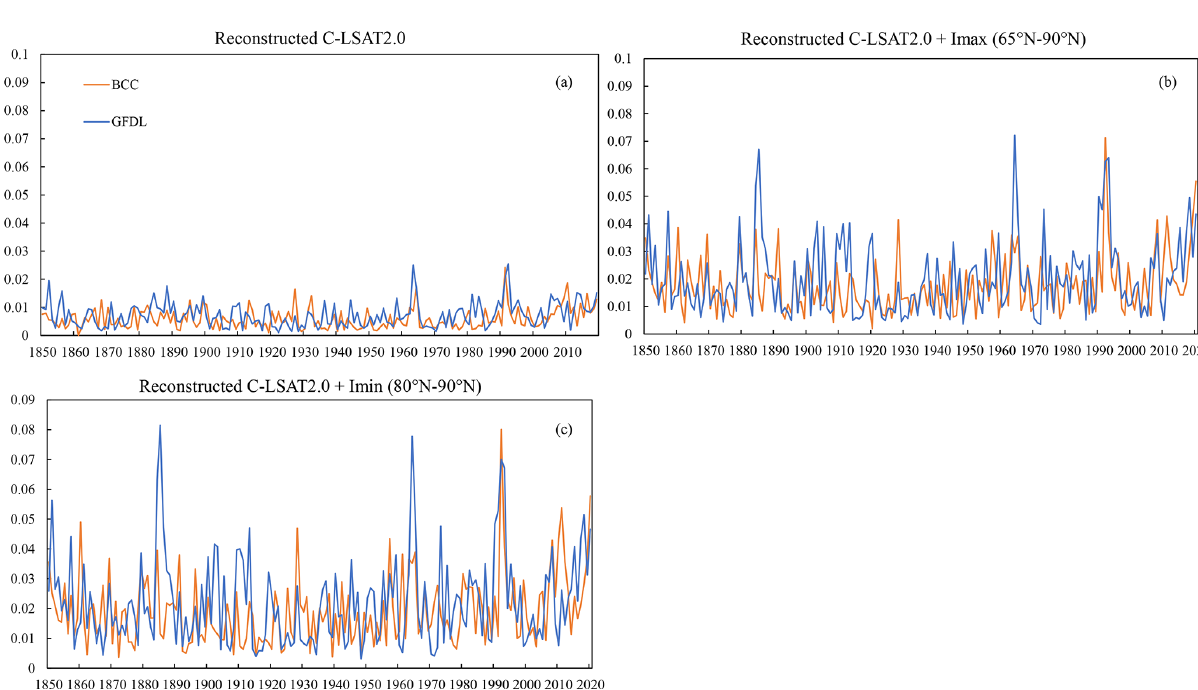
Figure 6. Reconstruction uncertainty in the reconstructed C-LSAT2.0 ensemble, reconstructed C-LSAT2.0 + Imax (65–90 ◦ N), and recon- structed C-LSAT2.0 + Imin (80–90 ◦ N) calculated using BCC-CSM2-MR and GFDL-ESM4.